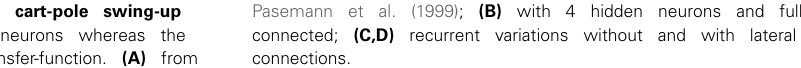
Pasemann et al. (1999); (B) with 4 hidden neurons and fully connected; (C,D) recurrent variations without and with lateral